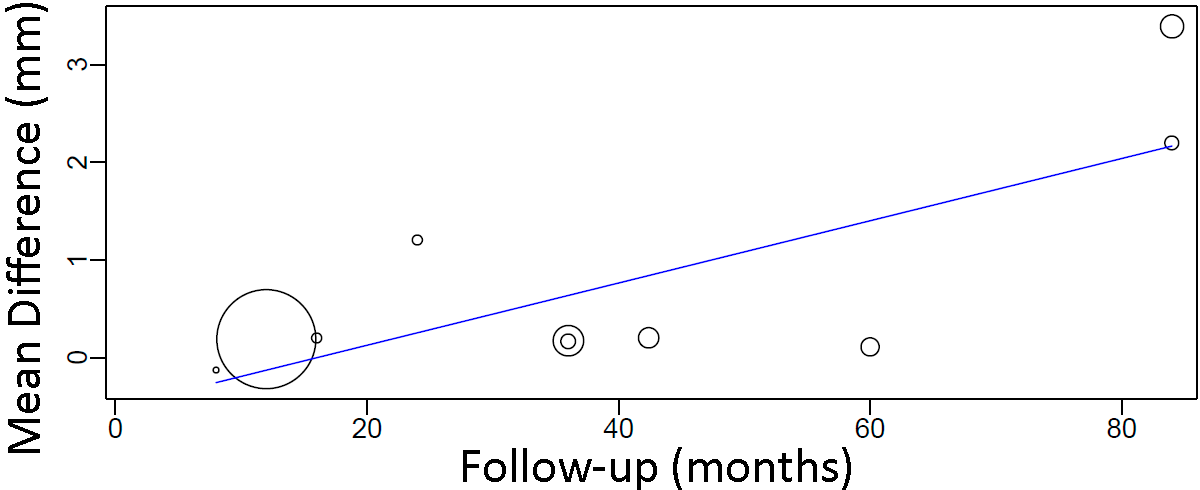
Figure 9. Scatter plot for the meta-regression with the association between follow-up (in months) and MBL mean difference between diabetic and non-diabetic individuals. Every circle represents a study and the size of the circle represents the weight of the study in the analysis.